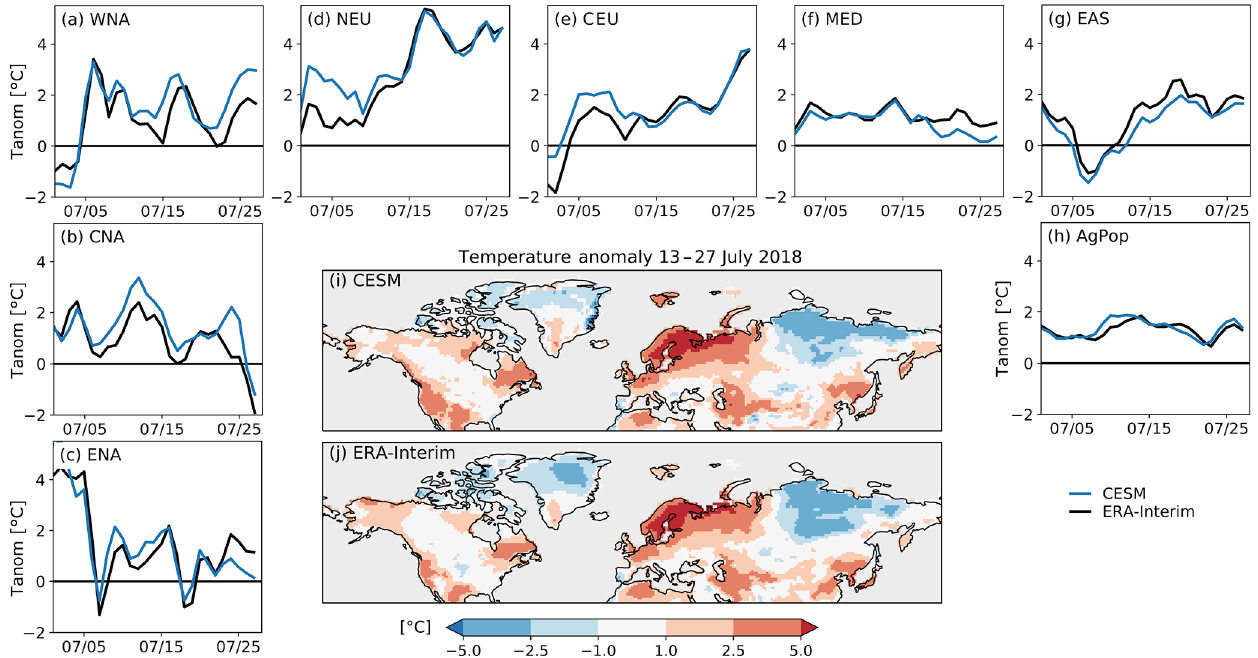
Figure 3. Anomalies of daily mean temperature with respect to the 1981–2010 climatology. The maps show the average anomaly over 13 to 27 July 2018 for (i) the nudged historical CESM simulation and (j) for ERA-Interim. The time series show the evolution of daily temperature anomaly (Tanom) for CESM (blue) and ERA-Interim (black) for the month of July averaged over (a–g) seven SREX regions as well as (h) for the AgPop